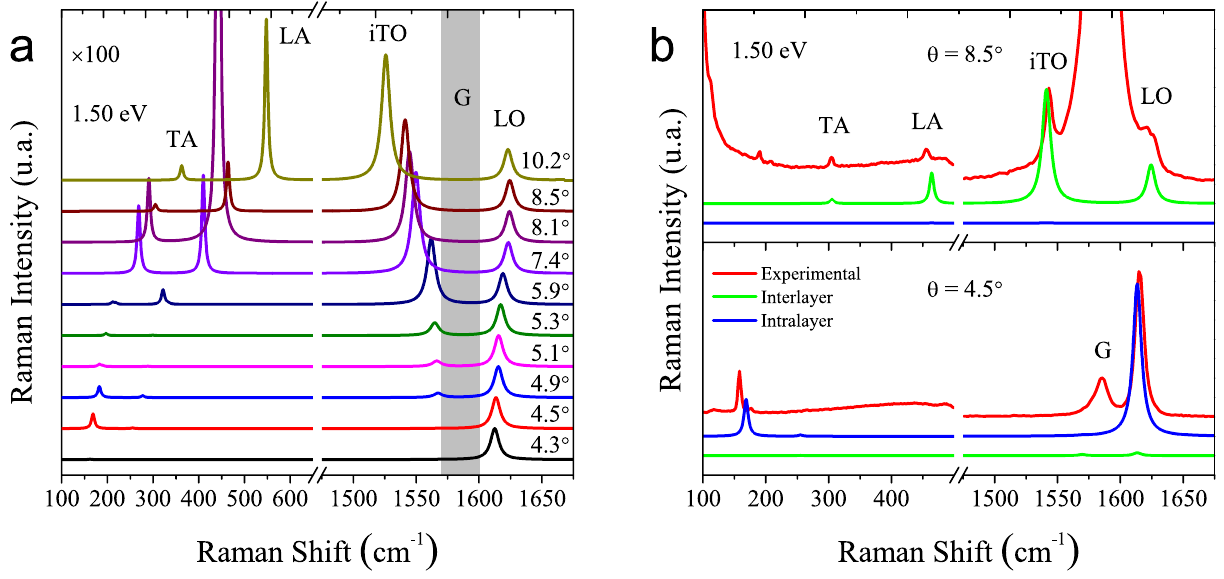
Figure 3. ( a ) Theoretical total Raman intensity for TBGs with the same angles of the experimental samples, between 4.3 ◦ and 10.2 ◦ . All spectra were calculated using the double-resonant Raman model described in the text, which includes interlayer and intralayer el–ph processes, for the excitation energy of 1.50 eV. The intensities in the acoustic region ( ω < 700 cm − 1 ), which shows the peaks associated to TA and LA modes, were enhanced by a factor of 100 for a better comparison with the optical region ( ω > 1400 cm − 1 ), that shows the iTO and LO peaks. The grey strip between 1570 cm − 1 and 1600 cm − 1 denotes the region of the G band, which is a first-order process not included in the calculations. ( b ) Theoretical Raman spectra of TBG structures for θ 4.5 ◦ showing separately the intralayer (blue curves) and interlayer (green curves) processes, for the excitation energy of 1.50 eV, compared with experimental measurements (red curves). In this case, the acoustic region was magnified by a factor of 50 compared to the optical one and all the theoretical frequencies shown in the figures 1 , in the optical and the acoustic region, 20 cm were shifted by − ±